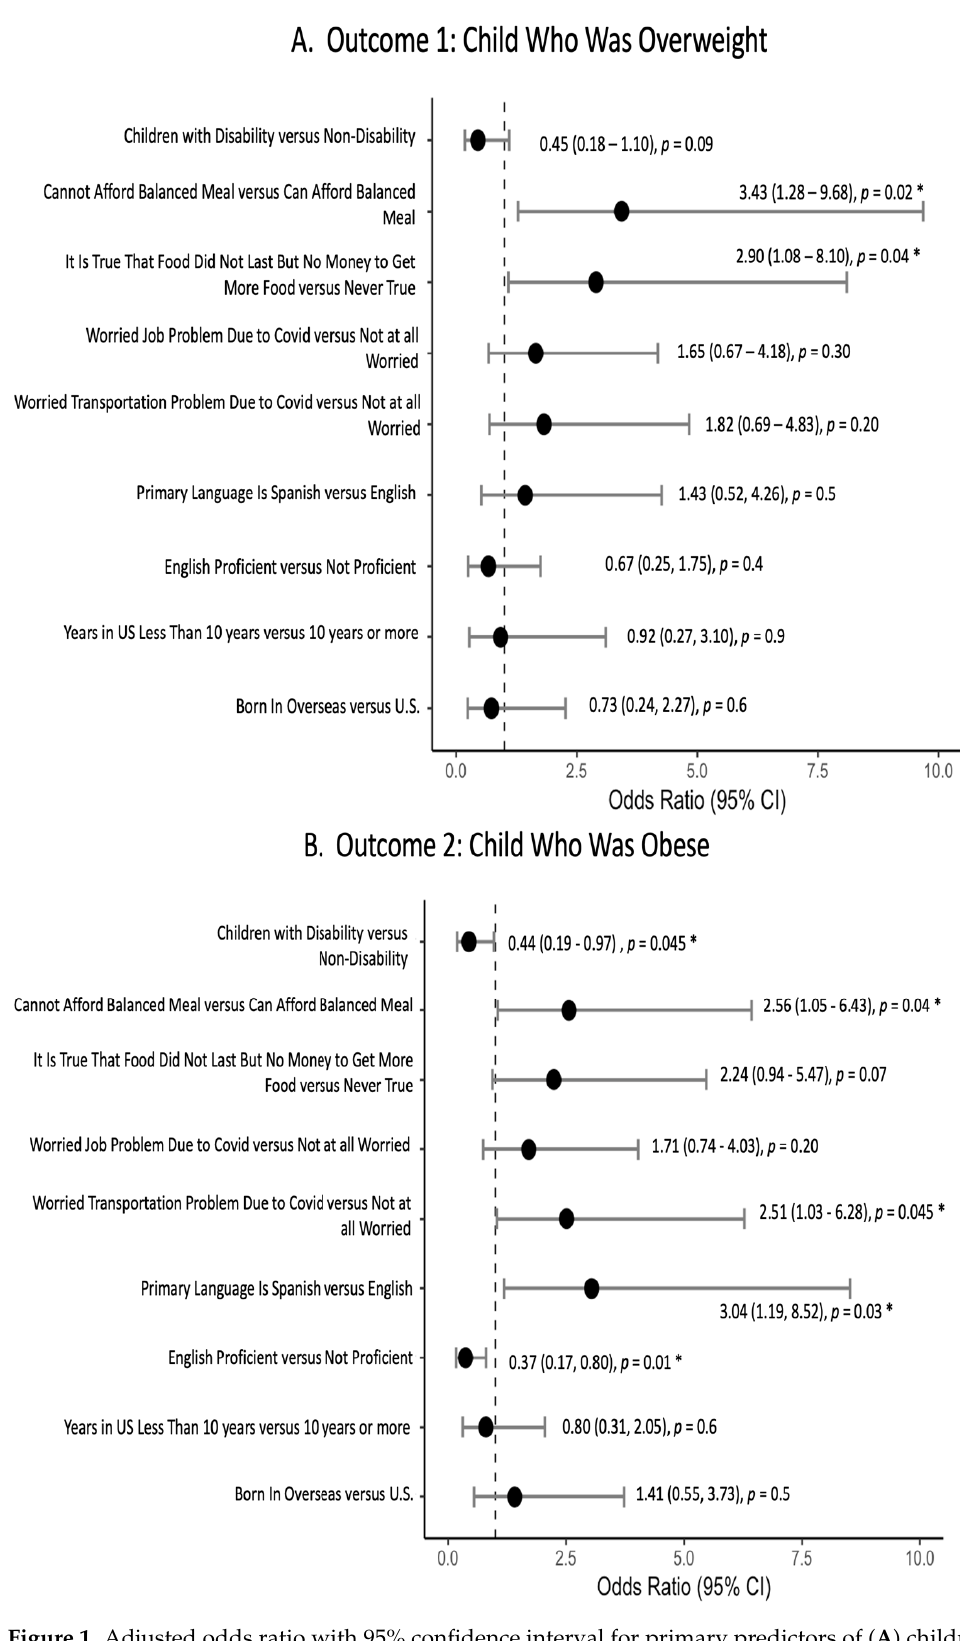
Figure 1. Adjusted odds ratio with 95% confidence interval for primary predictors of ( A ) children who are overweight and ( B ) children who are obese after multivariable adjustment, controlling for child age, child gender, and child race/ethnicity. * Indicates statistical significance.